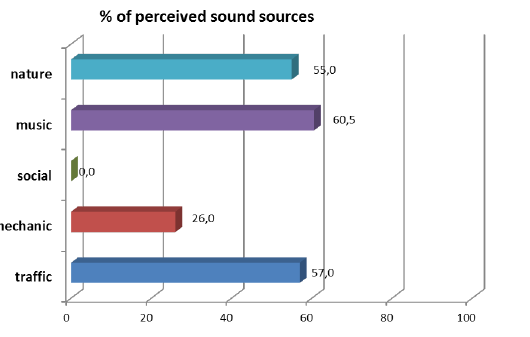
Figure 7: Number of noise events identified by the system during the observation at one place and evaluated as positive by participants. A total of 41 observations were developed.